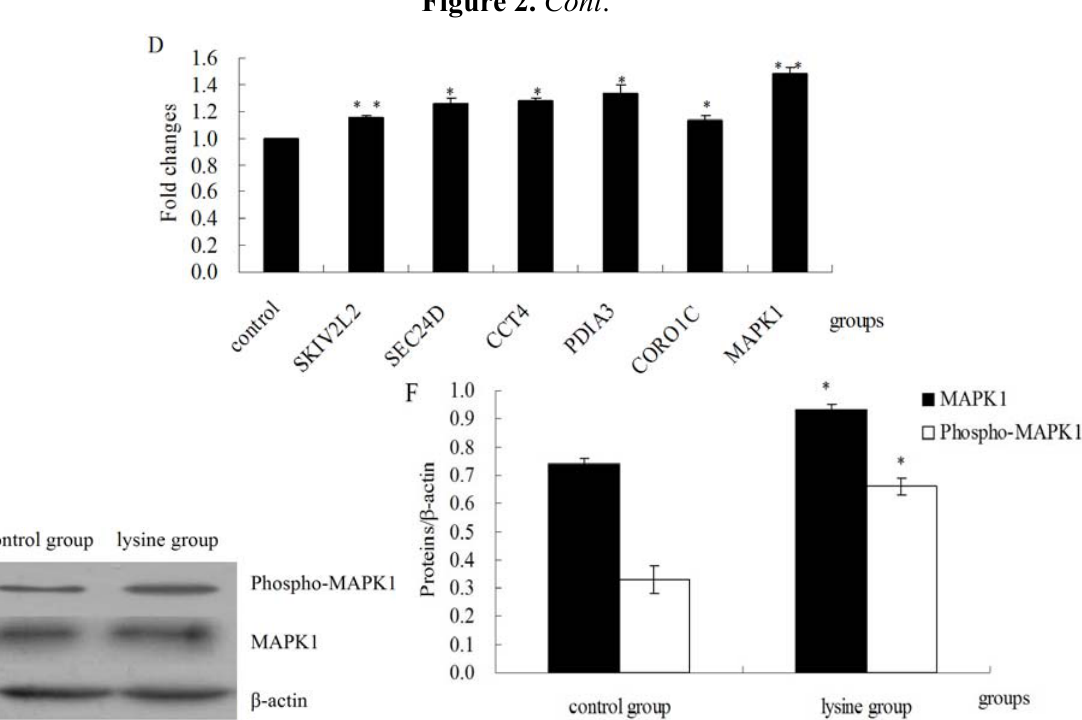
Table 1. MS identification of up-regulated expressed protein spots in Lys-treated DCMECs. Spot